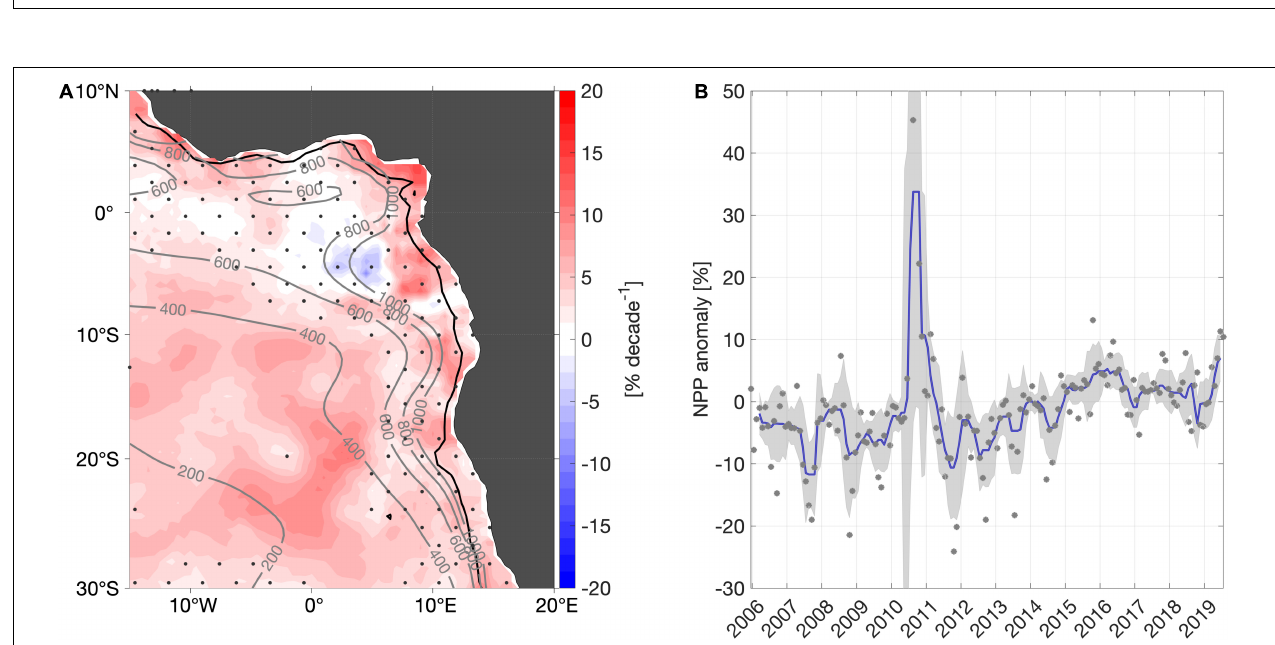
FIGURE 12 | Decadal trend of (A) latent heat flux anomaly, (B) specific humidity anomaly, and (C) evaporation anomaly from OAFlux data (2006–2019) and (D) latent heat flux anomaly and (E) specific humidity anomaly from TropFlux data (2006–2018) as well as (F) precipitation anomaly of GPCP data (2006–2019). All anomalies are computed relative to the corresponding monthly means. Note, a negative latent heat flux indicates that the ocean loses heat. Gray contour lines show the corresponding mean field. Areas where the trend is of 95% significance are stippled. Black line indicates the 2,000 dbar isobath of the shelf region.